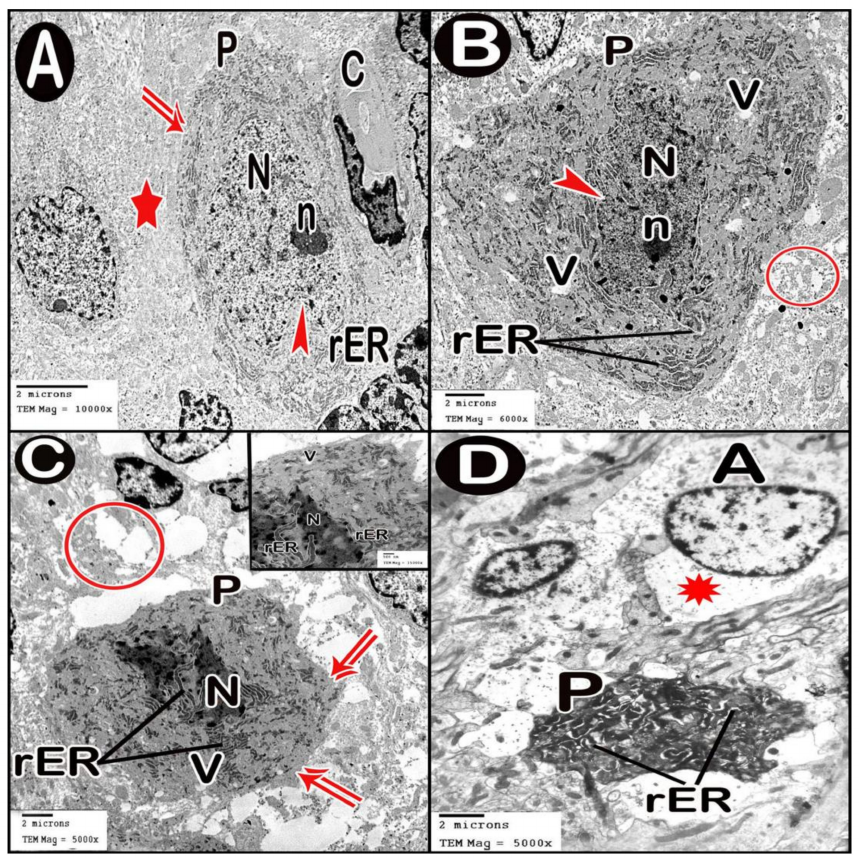
Figure 7. Electron micrographs of Purkinje cell layer. ( A ) control group. ( B ) low-dose group. ( C , D ) high-dose group. Purkinje cell (P), contour of cell membrane (double arrow), tight neuropil (star), blood capillary (C), nucleus (N) with indentation (arrow head), nucleolus (n), short profiles of rough endoplasmic reticulum cisternae (rER), swollen astrocytes (A) and loss of cytoplasmic organization